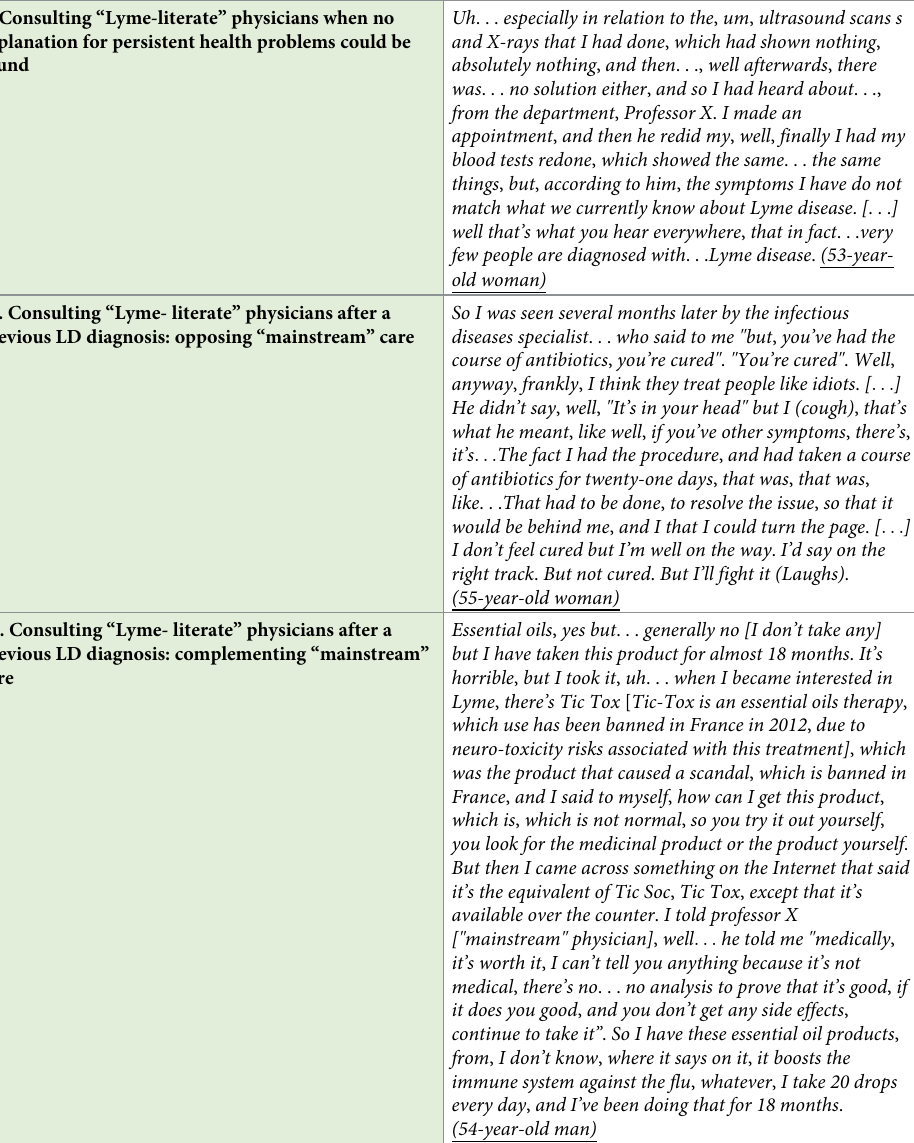
Table 4. Interpreting persistent health problems: The chronic Lyme disease